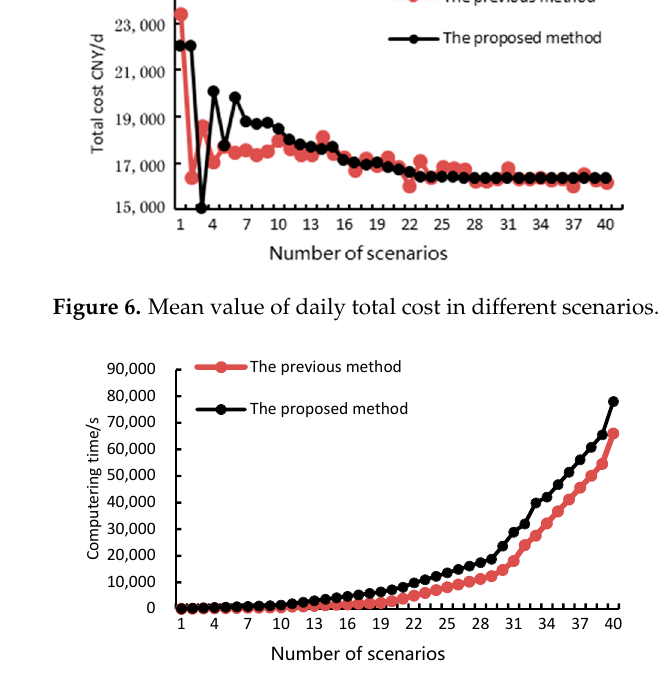
Figure 7. Computing time in different mean value of daily total cost.